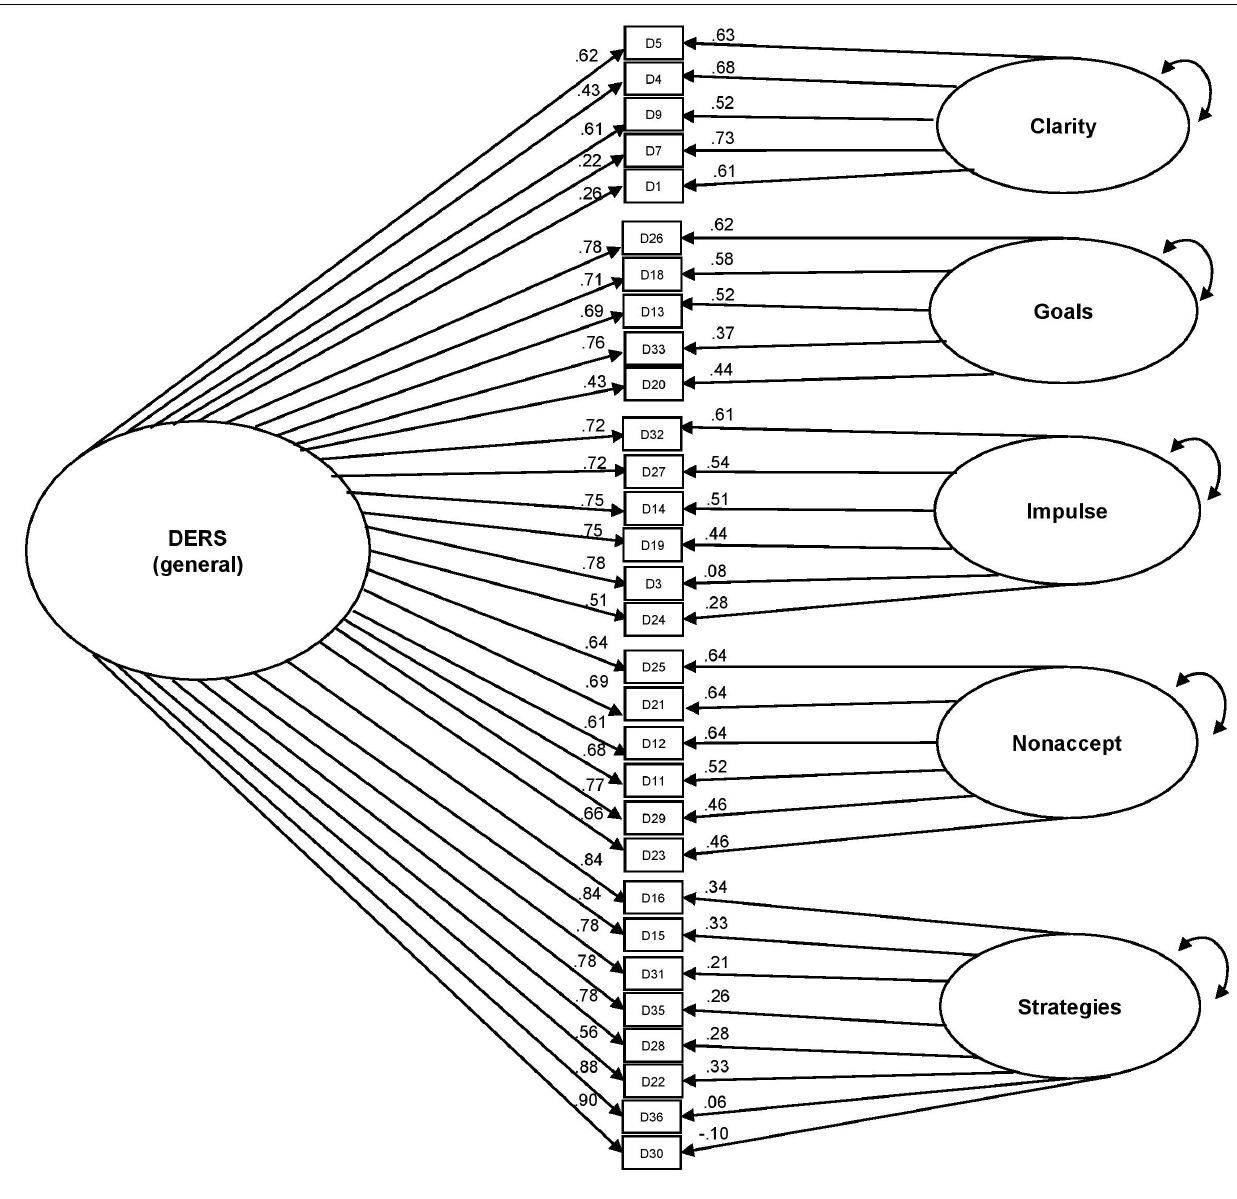
FIGURE 1 | Bifactor model of the DERS, excluding Awareness